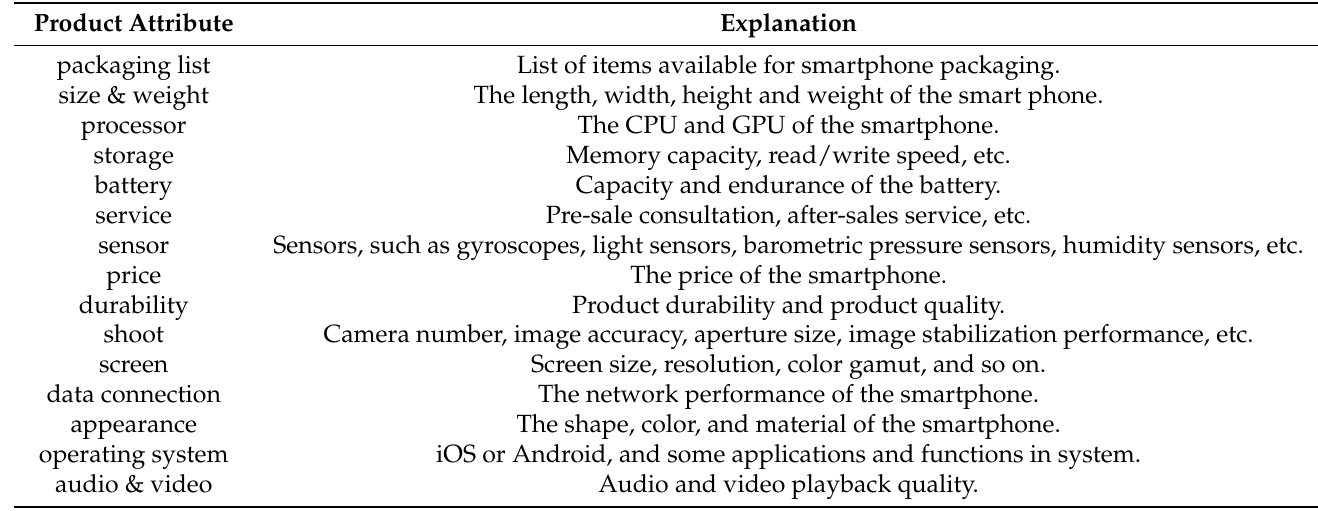
Table 1. The explanation of the product attributes.